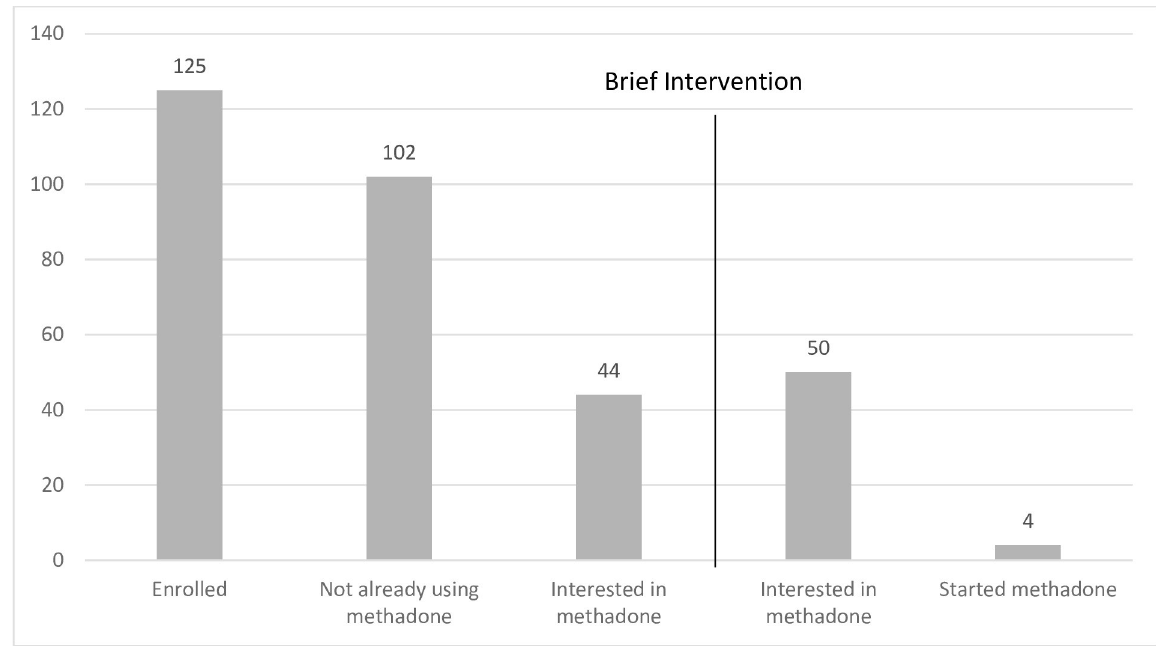
Fig 2. Methadone interest cascade for incarcerated Kyrgyz study population. 125 people were initially enrolled in the study, of whom 102 were not already participating in the methadone program. 44 expressed interest before a brief intervention, and 50 expressed interest after ( p = 1.00). However, only 4 people joined the methadone program following the intervention.